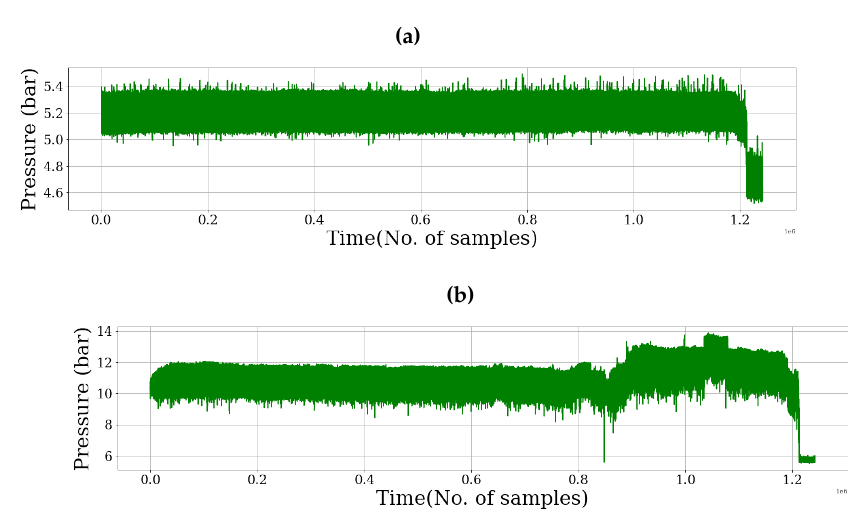
Figure 5. Pressure signals for the whole run-to-failure test (a) Suction, (b) Delivery. As observed in Figure 5, the time-series signals contain high frequency components which are most probably from noise and uncertain sources. The CEEMDAN algorithm was employed respectively on the suction and delivery pressure measurements to produce the IMFs shown in Figure 6 whereby the IMFs in red are from the suction pressure signal whereas the IMFs in blue are from the delivery pressure signal.